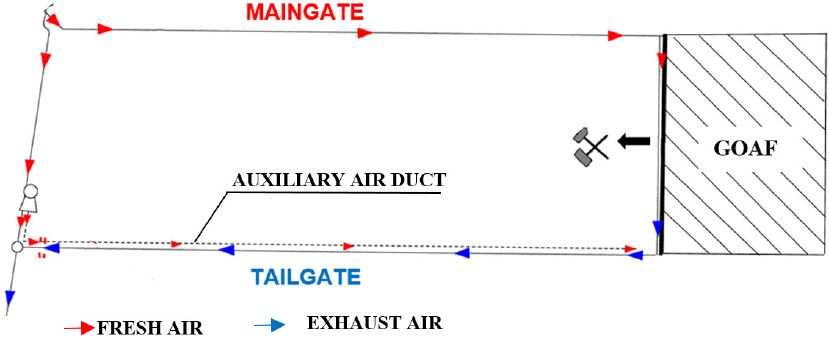
Figure 5. The ventilation scheme of the longwall under analysis.